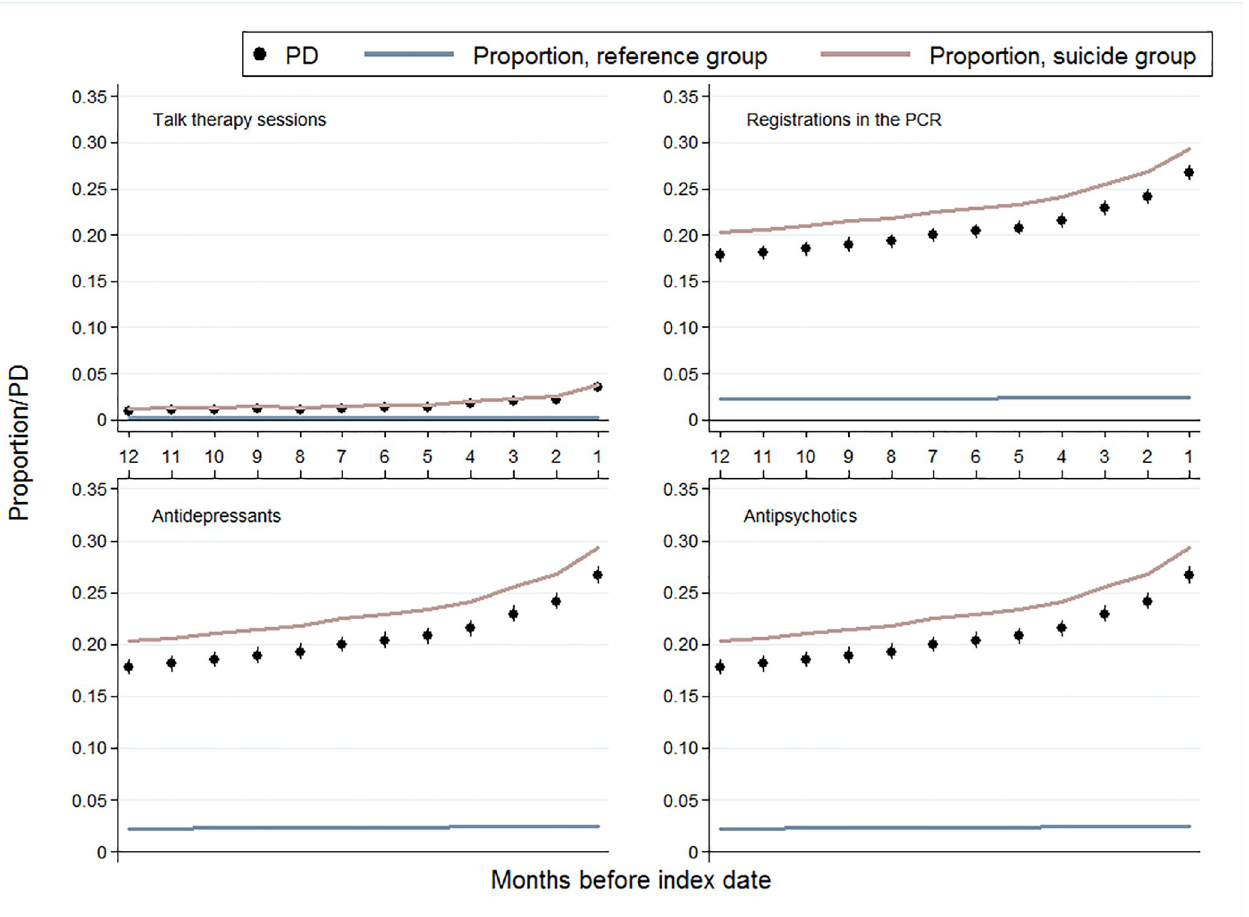
Fig 3. Talk therapy sessions, registrations in the PCR, and redeemed prescriptions for antidepressants, and antipsychotics stratified on months before suicide. All PD estimates are adjusted for age, sex, and calendar period.